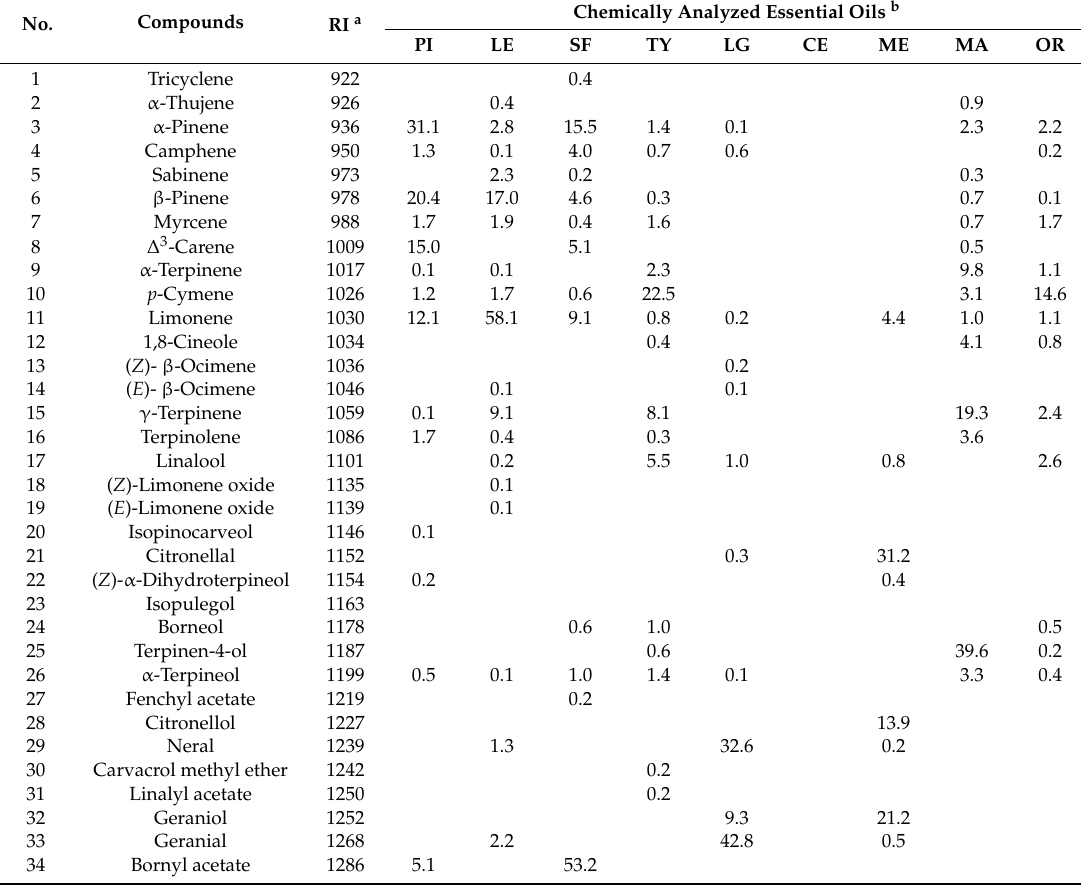
Table 2. Chemical composition of the analyzed essential